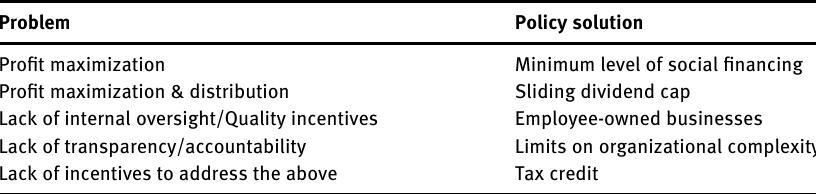
Table  : For-pro fi t long-term care problems and related fi nancial and legal policy